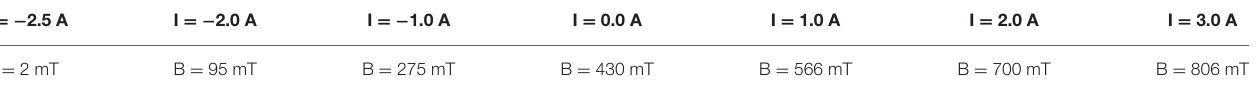
TABLE 1 | Magnetic flux density at the center of the MRE layers under different levels of applied current to the coils. I = − 2.5